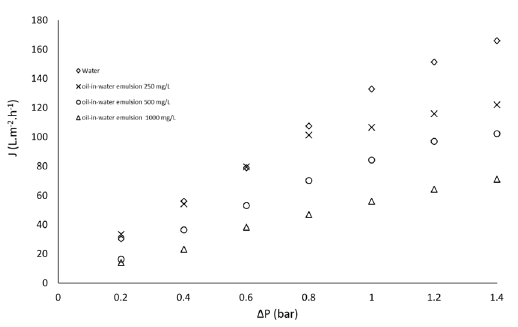
Figure 8. Variation of permeate flux with time at various operating conditions for the M1 membrane.